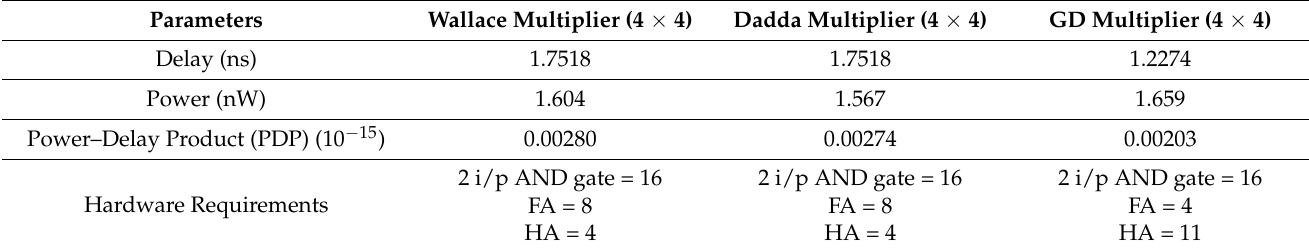
Table 2. Front-end design performance comparison between proposed GD architecture with existing multiplier architectures.